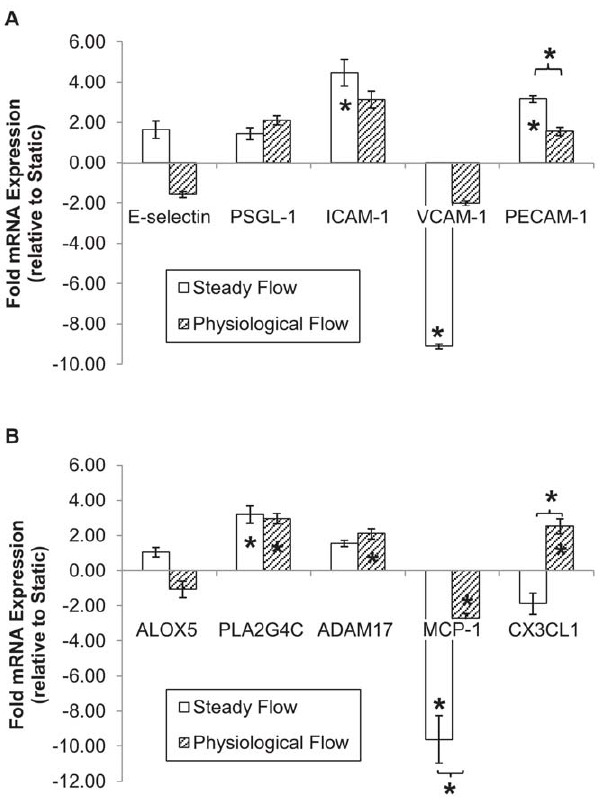
Figure 6. Inflammation-associated gene expression in flow- conditioned endothelial cells. Shown is fold mRNA expression (with respect to static-cultured endothelial cells) of cell adhesion molecules (A) and genes with roles in recruitment of inflammatory cells (B). Results are presented as mean 6 SEM. An embedded asterisk indicates a significant difference with respect to static controls; an asterisk over a bracket indicates a significant difference between flow groups. Abbreviations: PSGL-1 : P-selectin glycoprotein ligand-1; ICAM-1 : inter- cellular adhesion molecule-1; VCAM-1 : vascular cell adhesion molecule- 1; PECAM-1 : platelet-endothelial cell adhesion molecule-1; ALOX5 : arachidonate 5-lipoxygenase; PLA2G4C : cytosolic phospholipase A2 gamma; ADAM17 : ADAM metallopeptidase domain 17; MCP-1 : mono- cyte chemoattractant protein-1; CX3CL1 : fractalkine.